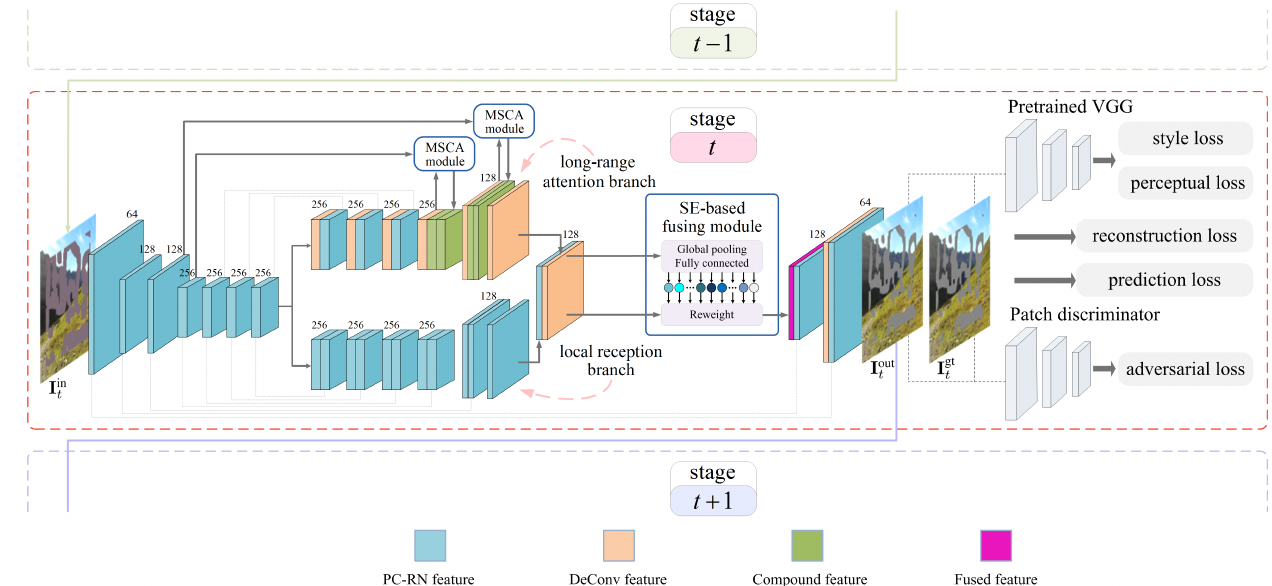
Figure 1. The overall architecture of the proposed inpainting network. Details of the MSCA module and the SE-based fusing module are illustrated schematically in Figure 2 and Figure 3, respectively.